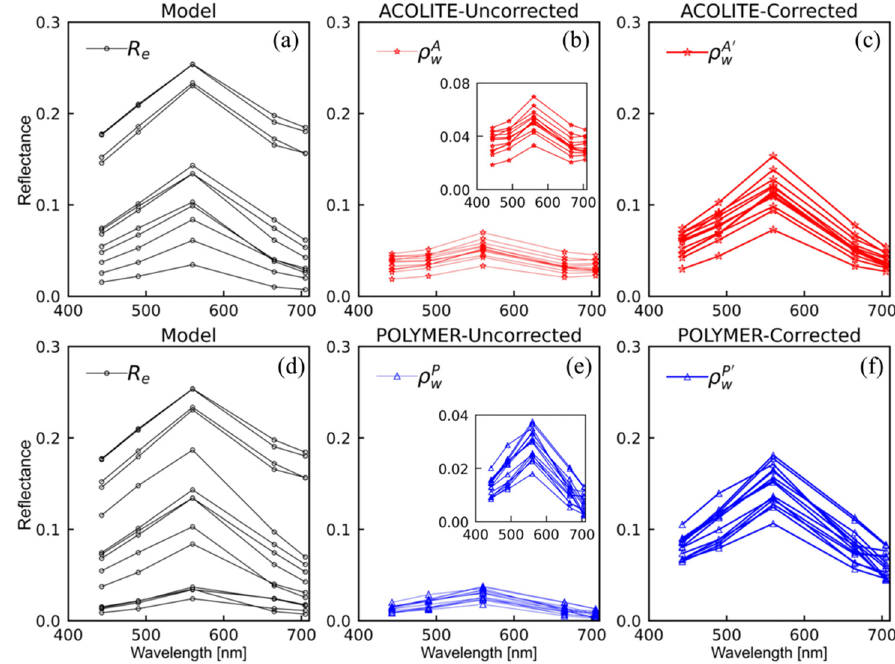
Figure A3. Spectral comparisons of modelled ( R e first column ), uncorrected satellite-observed ( ρ w , second column ), and corrected satellite-observed ( ρ w (cid:48) , third column ) reflectances. The insets show the reflectance spectra of ρ A w ( b ) and ρ P w ( e ) at smaller scales to demonstrate their actual magnitude and spectral features.